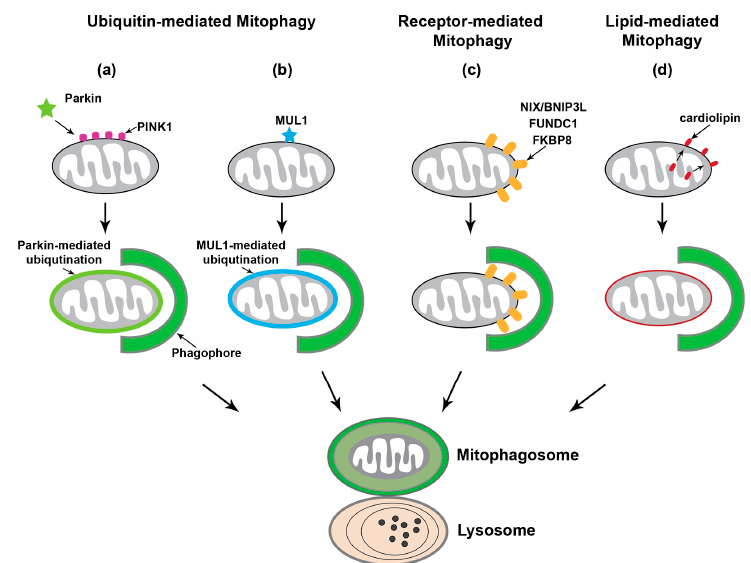
Figure 1. The mitophagy pathways. Upon mitochondrial damage, mitophagy can be induced through three major mechanisms: ubiquitin-mediated mitophagy including PTEN-induced putative kinase protein 1 (PINK1)-Parkin-dependent mitophagy, outer mitochondrial membrane (OMM) receptor-mediated mitophagy, and lipid-mediated mitophagy. ( a ) PINK1-Parkin-mediated mitophagy initiates with PINK1 stabilization on the OMM of damaged mitochondria to recruit Parkin, an E3 ubiquitin ligase. Phospho-ubiquitinationofsubstratesontheOMMbyPINK1 / Parkinrecruitstheautophagymachineryand thus promotes the engulfment of damaged mitochondria by growing phagophore or isolation membranes. ( b ) Other E3 ubiquitin ligases have been reported to regulate mitophagy independent of PINK1 and Parkin. MUL1 has similar substrates to Parkin and can directly bind to GABAA receptor-associated protein (GABARAP), suggesting that MUL1 can function independently to facilitate autophagic engulfment. ( c ) Several autophagy receptors are anchored within the OMM, including NIP3-like protein X (NIX;